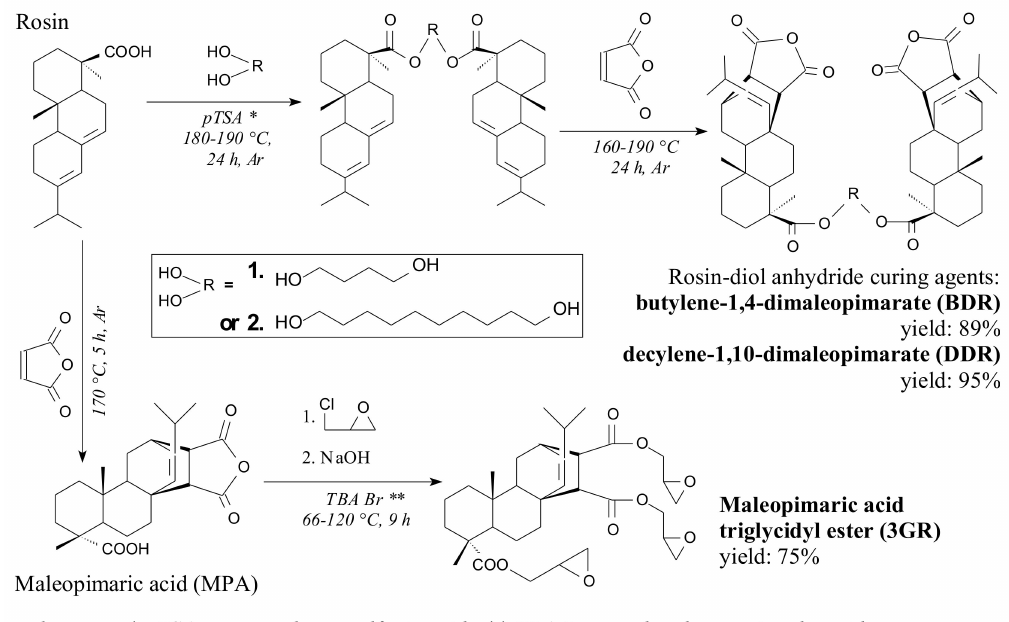
Figure 1. Preparation routes of rosin-derived anhydride curing agents and epoxy